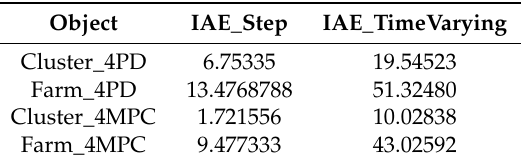
Table 1. IAE(integrated absolute